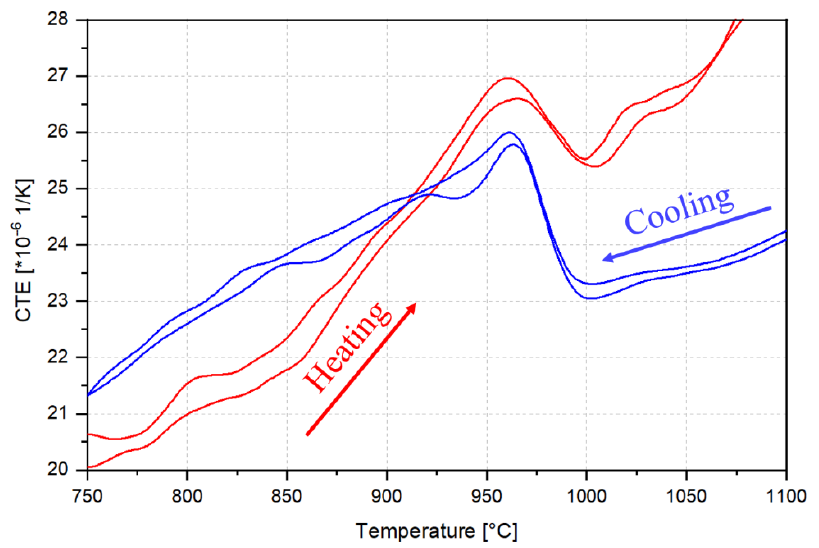
Figure 8. Representative CTE a curves as functions of temperature during heating and cooling of the 6Al steel at 5 K/s.